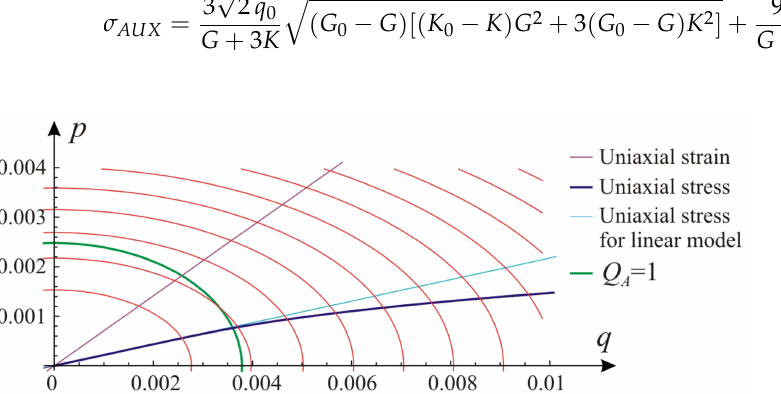
Figure 6. Contours of elastic strain energy for compressible nonlinear material for K 0 = 56,700 MPa, G 0 = 26,200 MPa, K = 16,200 MPa, G = 65 MPa, q 0 = 0.00379, n =